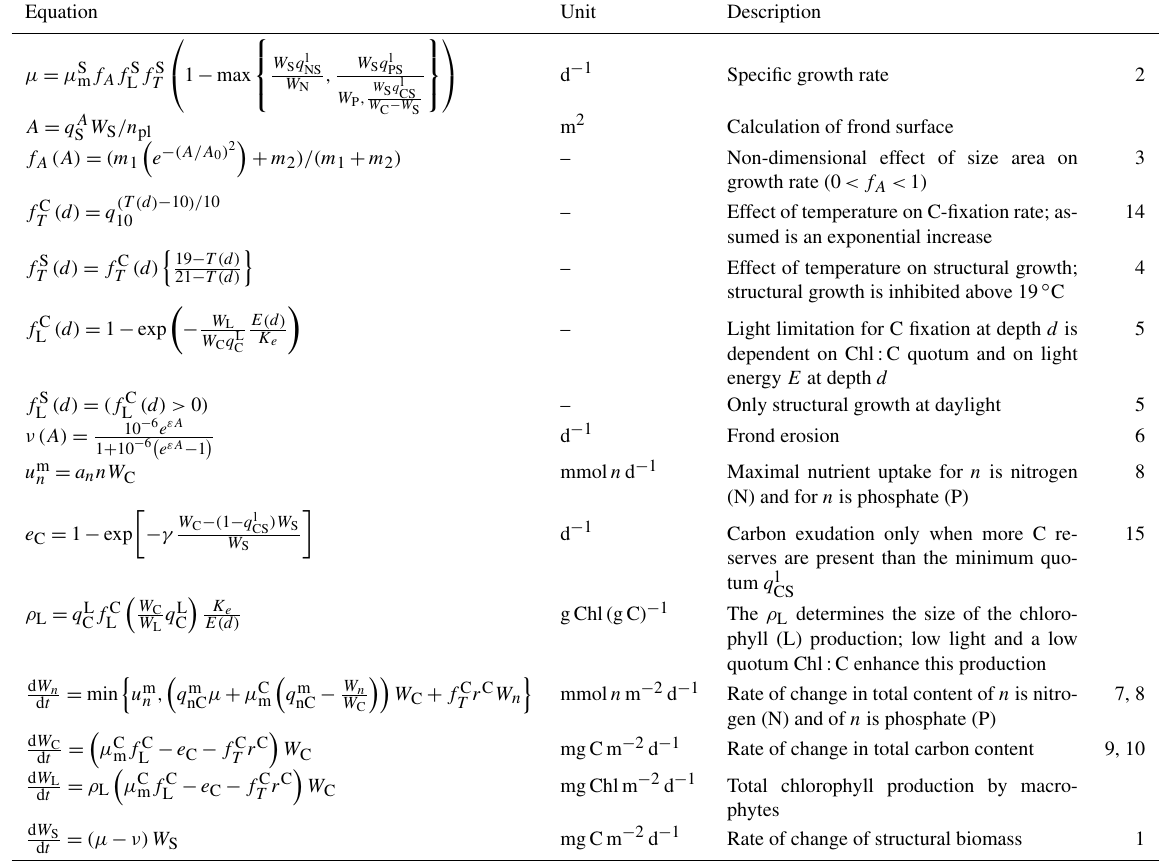
Table 3. Equations of the macroalgae model. The last column lists the numbers of the corresponding equations used by Broch and Slagstad (2012). Equation Unit